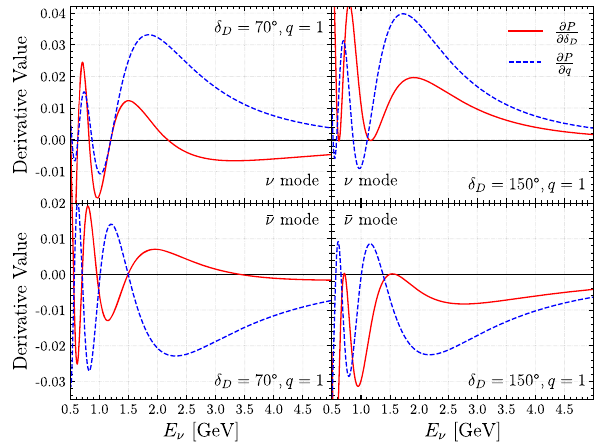
Fig. 15 Oscillation probability derivatives ∂ P /∂δ D (red solid) and ∂ P /∂ q (blue dashed) with respect to the matter effect parameter q at q = 1 and the Dirac CP phase δ D , respectively. Both neutrino and anti- neutrino modes are shown in the upper and lower rows for comparison. The left column adopts δ D = 70 ◦ while the right one takes δ D = 150 ◦